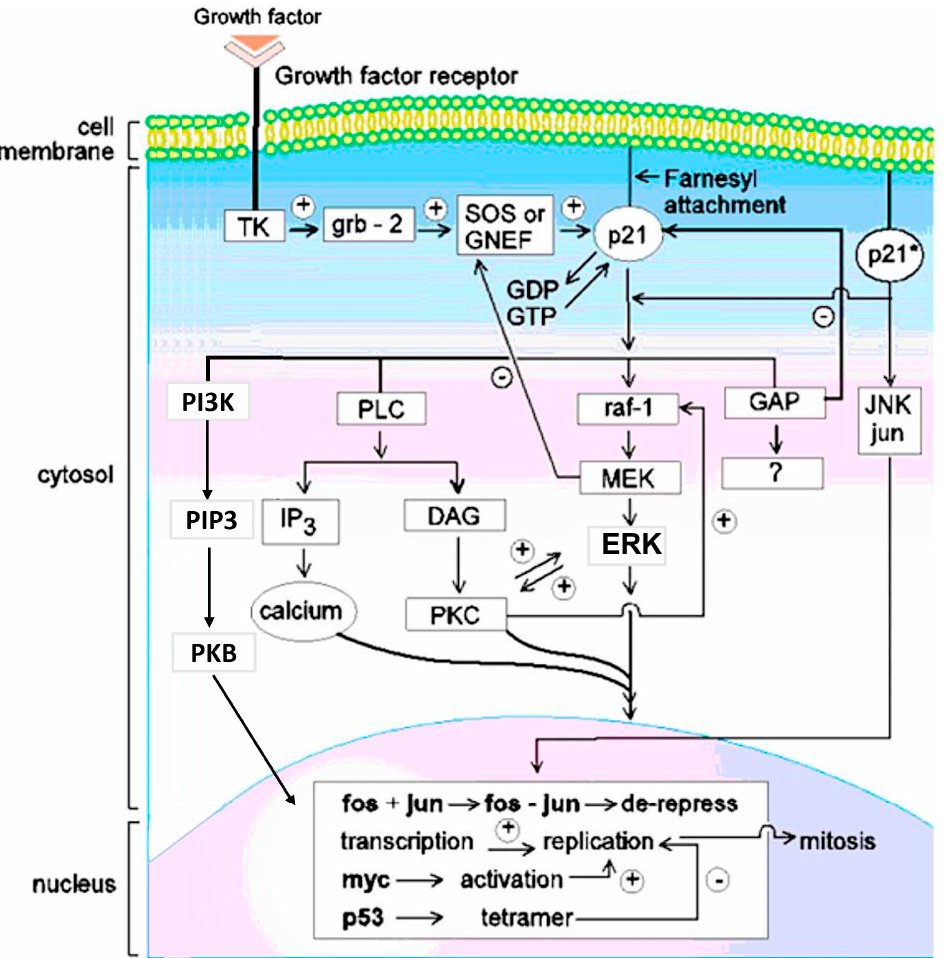
Figure 1. Pincus et al. Wild-type (RAS-p21) and Oncogenic (RAS-p21*) Signal Transduction Pathways. A growth factor such as EGF or insulin binds to its receptor (upper left)—for example, EGFR—extracellularly. The receptor contains three domains: the extracellular growth factor-binding domain, the trans-membrane domain and the intracytosolic domain. The latter contains a tyrosine kinase (TK in the figure) which becomes activated when the receptors dimerize upon binding to the growth factor. This event enables the intracytosolic domain to bind to the adapter grb-2 protein that concurrently binds to and activates a guanine nucleotide exchange factor (GNEF), SOS, a protein that in turn binds to RAS-p21, causing it to exchange GDP for GTP. In the GTP-bound state, RAS-p21 becomes activated. In its activated state, it induces mitogenic signal transduction which occurs only if RAS-p21 is bound to the inner surface of the cell membrane through a covalently attached farnesyl moiety in thioether linkage to Cys 186 catalyzed by the enzyme, farnesyl transferase. If RAS-p21 is not membrane-bound, it acts as a competitive inhibitor of membrane-bound ras. An important